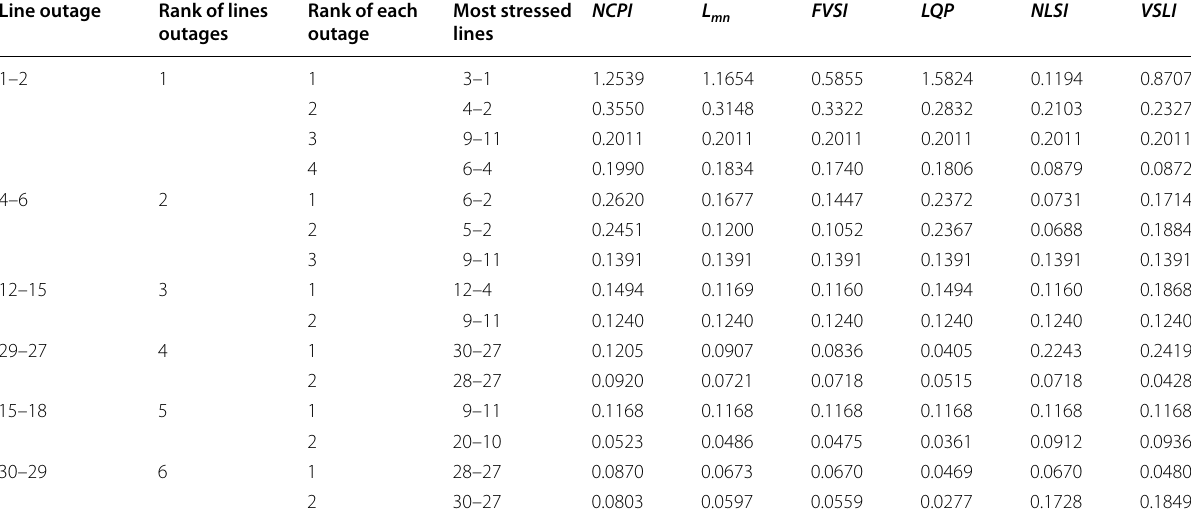
Table 9 Contingency ranking and analysis of the IEEE 30-bus system under the base case loadings Line outage Rank of lines Rank of each outages